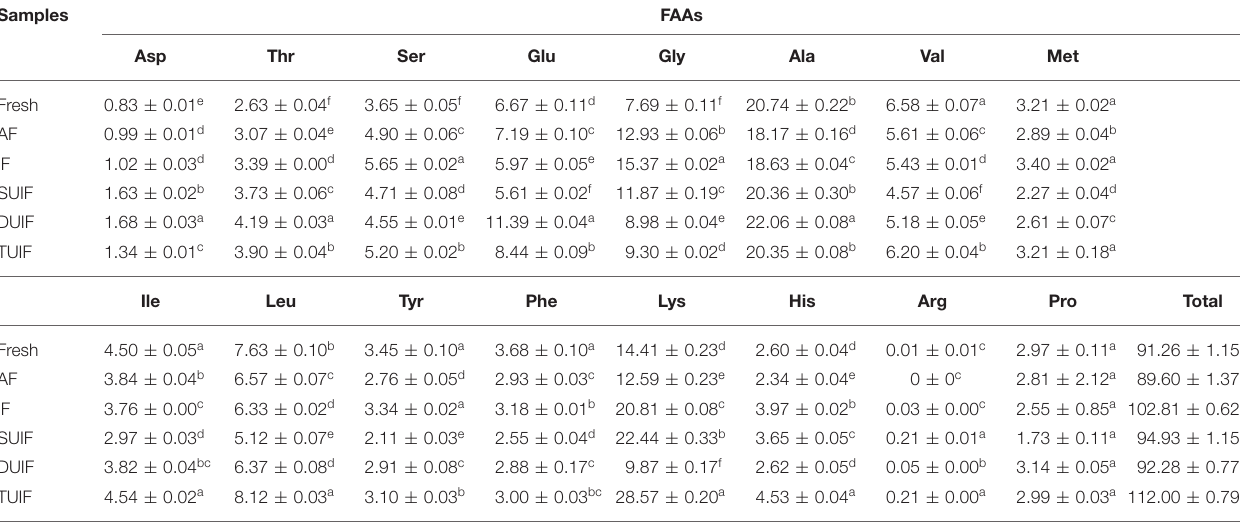
TABLE 2 | Changes in free amino acids (FAAs) content (mg/100g) of large yellow croaker muscles after different freezing treatments.